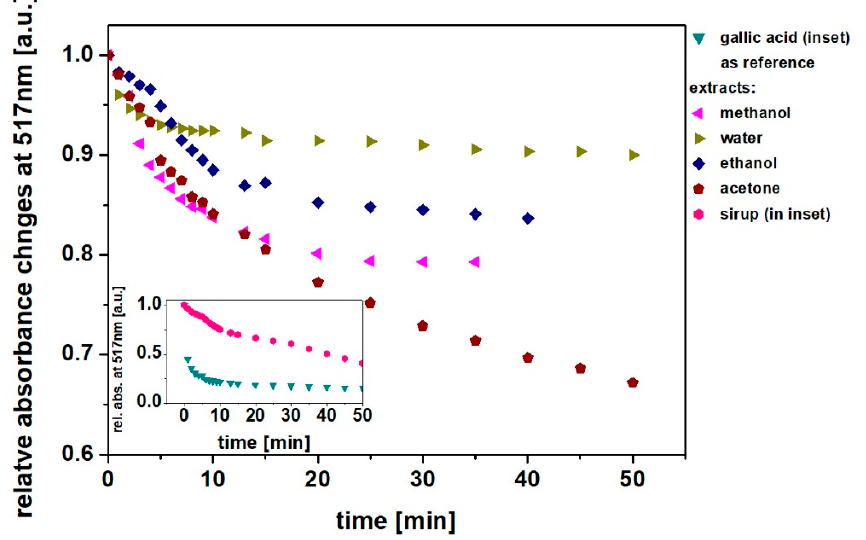
Figure 7. Scavenging kinetics of DPPH free radical in methanol by examined extracts. Inset shows the kinetics of gallic acid and sirup, as they are very effective scavengers.